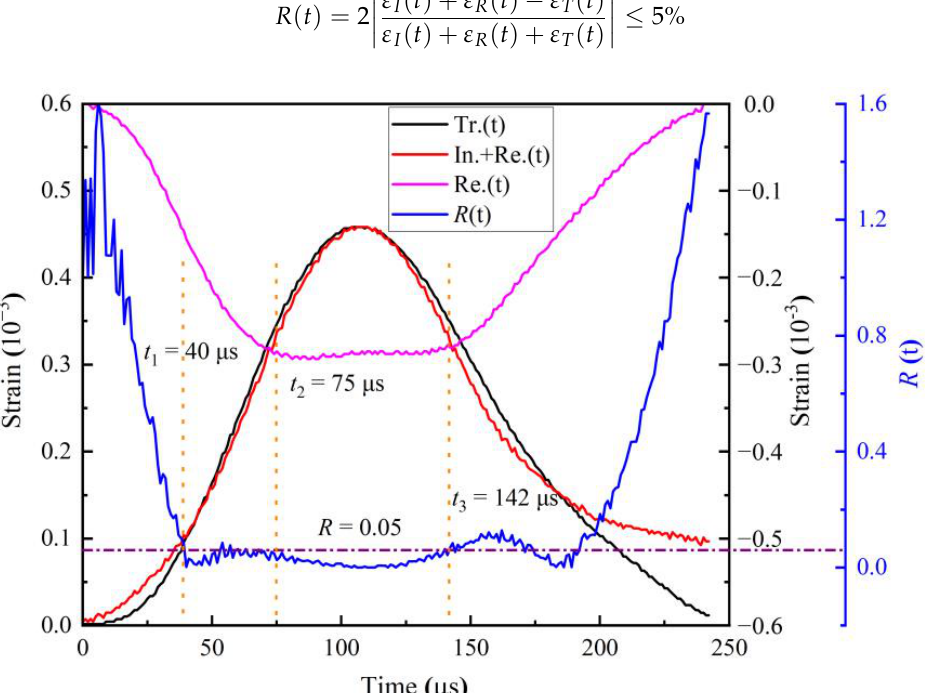
Figure 4. Dynamic stress equilibrium and the stress equilibrium factor R ( t )